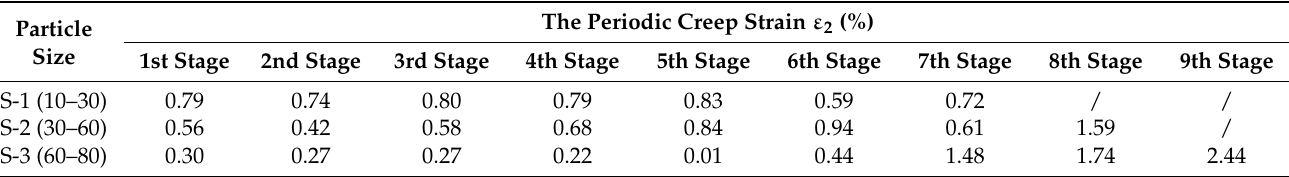
The Periodic Creep Strain ε 2 (%)